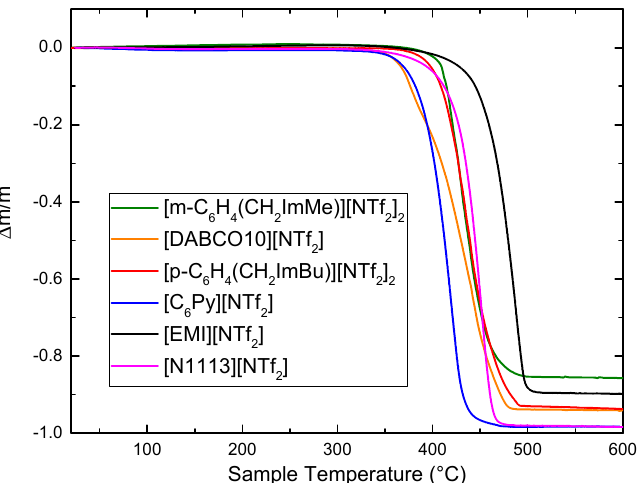
Figure 1. TGA curves of the four ILs investigated in this work; for comparison the TGA curves of [EMI][NTf 2 ] and [N1113][NTf 2 ] are reported [24].